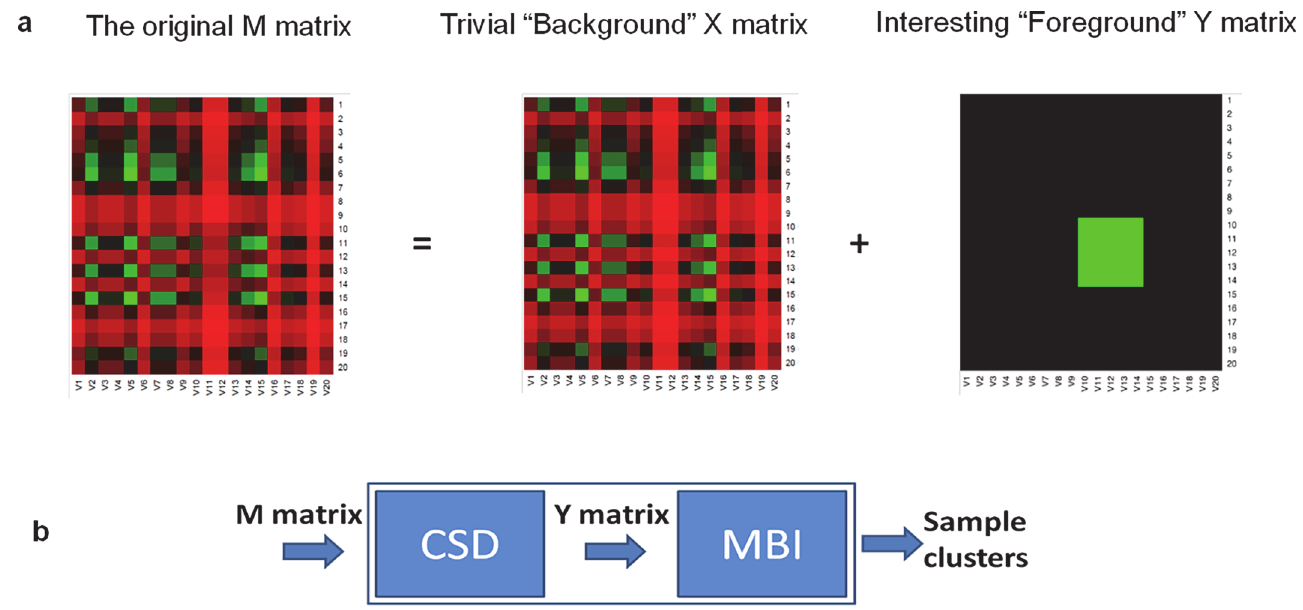
Fig 1. Overview of the new clustering framework. (a) An artificial example: Given the input gene expression M matrix, where are the “ interesting genes ” hidden? (i.e., which are the genes significant for distinguishing the potential different molecular subtypes?) The “ interesting ” genes are not easily detected from the given M matrix using the current popular clustering methods, e.g., NMF or Hclust. However, we could clearly see the “ foreground ” (a co-cluster of size 5×5, shown in green of the Y matrix) after the distractive “ background ” X matrix is removed through the decomposition. The “ interesting ” genes (rows 10 – 14) are differentially expressed for samples/columns 10 – 14 of the Y matrix. (b) The new clustering framework. This new framework includes two modules: the common-background and sparse-foreground decomposition (CSD) and the Maximum Block Improvement (MBI) co-clustering. Given an M matrix, the CSD module will decompose M and generate a “ foreground ” Y matrix; Then, the MBI co-clustering module will work on the Y matrix and output the co-clusters, providing the information of groups of samples and groups of genes that are associated with certain groups of samples. Our clustering framework conducts clustering by “ sparse-foreground ” commonality , while many current clustering methods usually conduct clustering by “ background ” commonality .